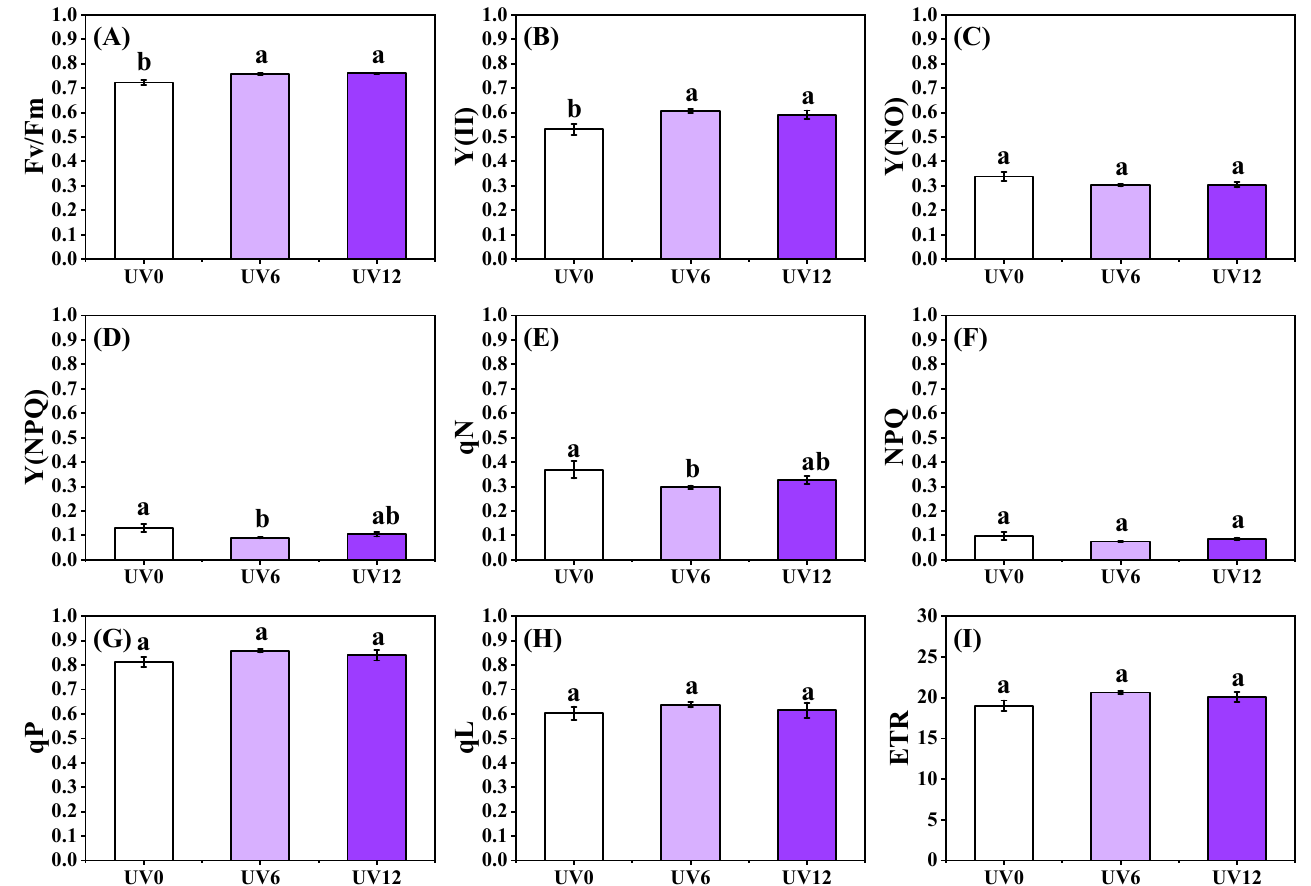
Figure 4. ChlF properties of Chinese kale subjected to different durations of UVA-radiation exposure. ( A ) Fv/Fm. ( B ) Y(II). ( C ) Y(NO). ( D ) Y(NPQ). ( E ) qN. ( F ) NPQ. ( G ) qP. ( H ) qL. ( I ) ETR. Different lowercase letters (a,b) labeled on the vertical bar (means ± standard error, n = 3) represent significant differences by one-way ANOVA with multiple-range tests ( p ≤ 0.05).